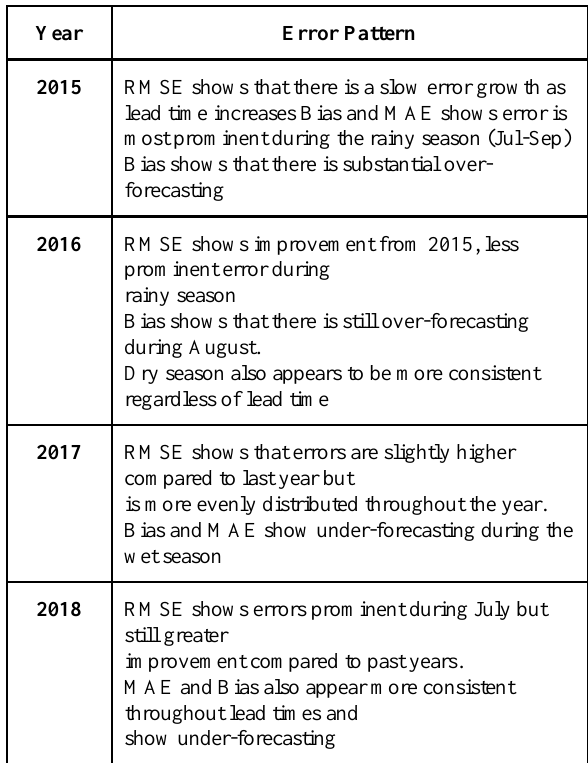
Table 2. Comparison of the error distribution per